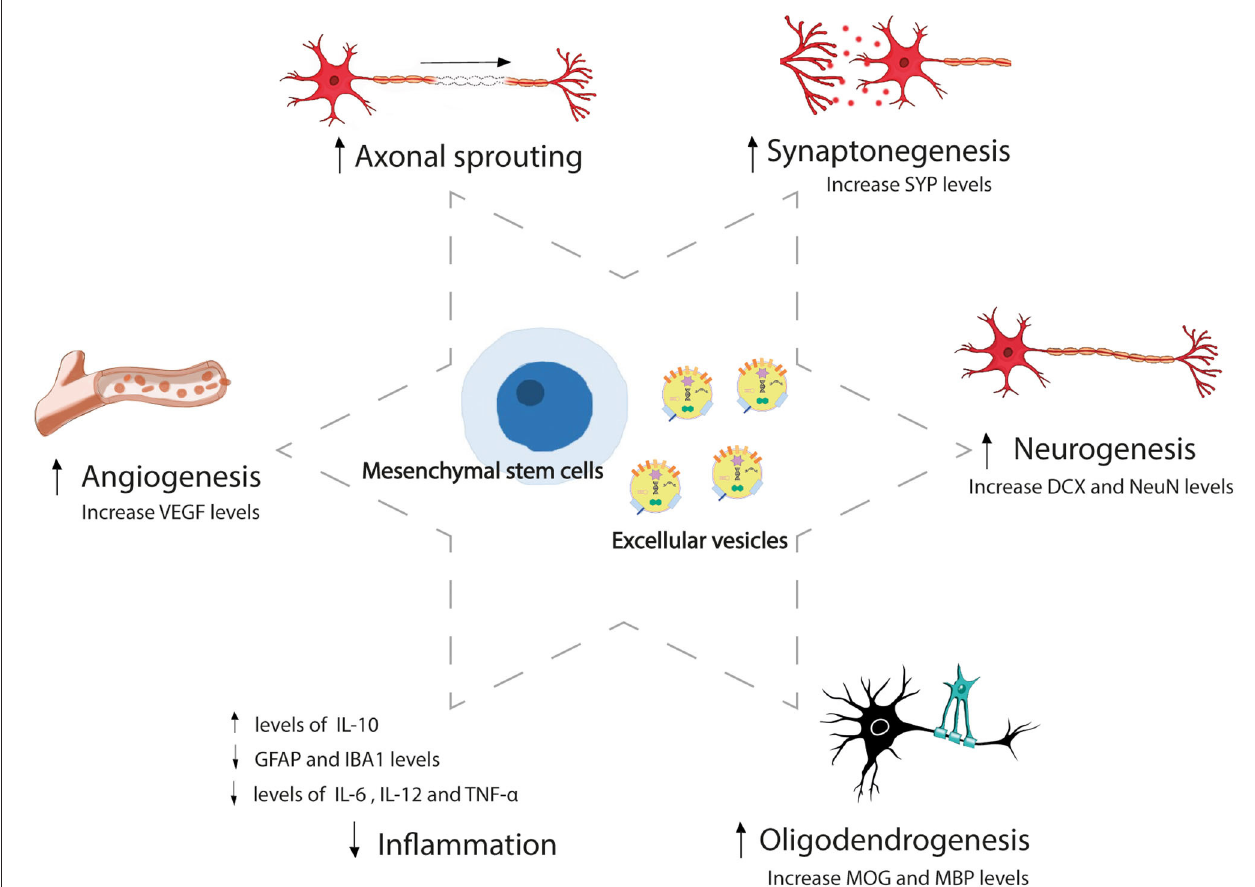
FIGURE 1 | Mesenchymal stem cell and extracellular vesicles-induced brain repair process after stroke. Mesenchymal stem cells and extracellular vesicles administration-induced brain plasticity that involves adaptive structural and functional changes, including angiogenesis, axonal sprouting, synaptogenesis, neurogenesis, oligodendrogenesis, and inflammation modulation after stroke. SYP, synaptophysin; DCX, doublecortin; NeuN, neuronal nuclear protein; MOG, myelin-oligodendrocyte glycoprotein; MBP, myelin basic protein; IL, interleukin; GFAP, glial fibrillary acidic protein; IBA, ionized calcium-binding adapter molecule; TNF, tumor necrosis factor; VEGF, vascular endothelial growth